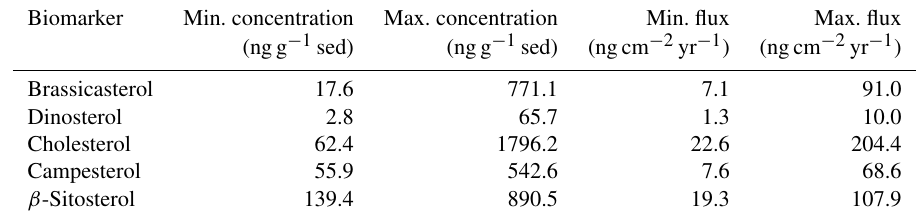
Table 3. Ranges of sterol biomarker concentrations and fluxes in OD1507-03TC-41GC-03PC.